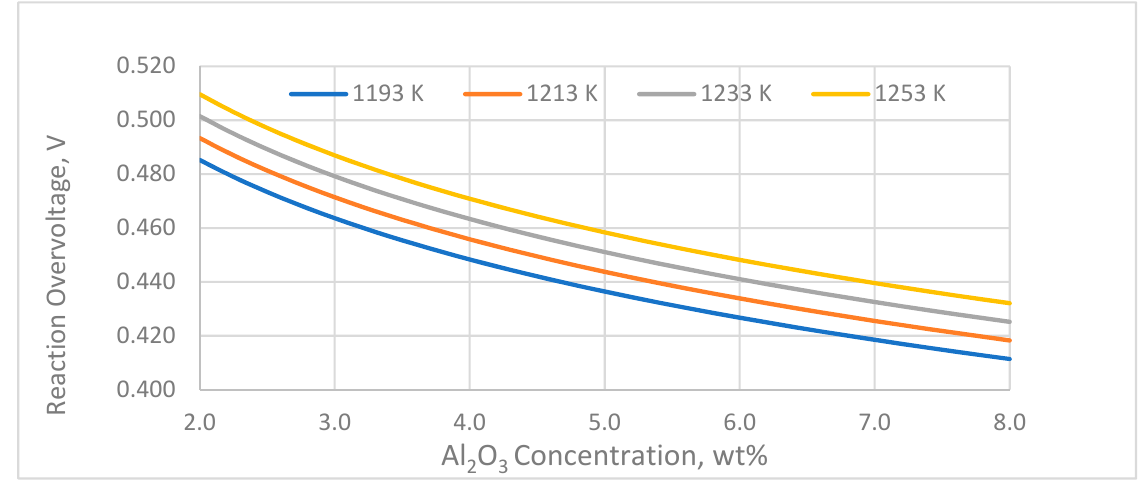
Figure 6. Effect of temperature and alumina concentration on the reaction overvoltage.